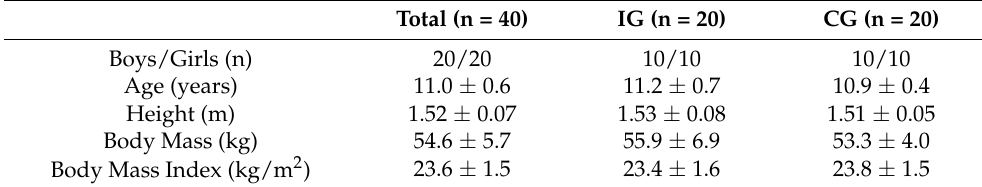
Table 1. Subject’s characteristics at baseline (Mean ± SD).